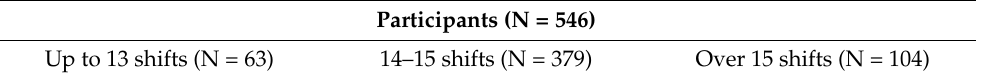
Table 2. The group size of the Polish ECDs subgroups separated according to number of shifts per